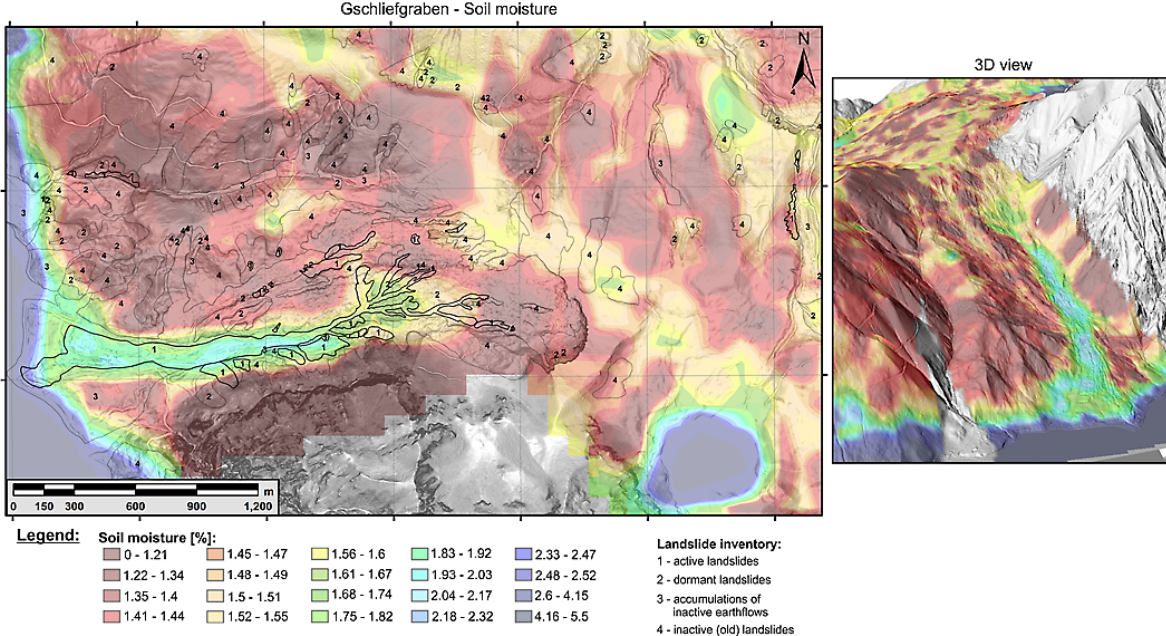
Fig. 14. Map of the soil moisture near the ground surface, which was obtained from the passive-microwave survey, compared to the landslide- inventory